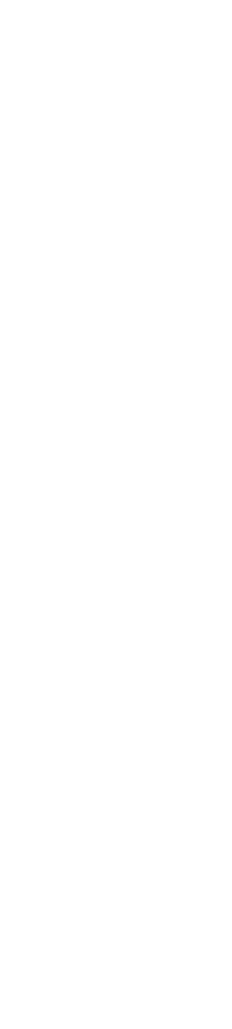
FIGURE 13 | RT-PCR detection of the hub gene in normal and gastric adenocarcinoma tissues. (A) TP53 expression level. (B) PCMT1 expression level. (C) HUWE1 expression level. (D) HDAC1 expression level. (E) EWSR1 expression level. (F) ESR1 expression level. (G) CLTC expression level. * P < 0.05, ** P < 0.01, and *** P < 0.001, control versus tumor, were considered to be statistically signi fi cant